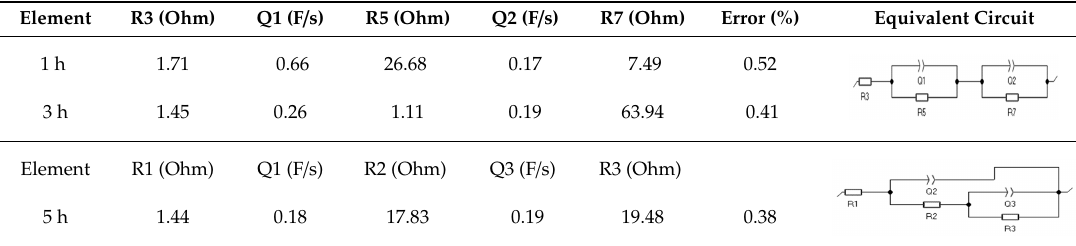
Table 4. Electrochemical parameters obtained from EIS tests of OCI alloy.